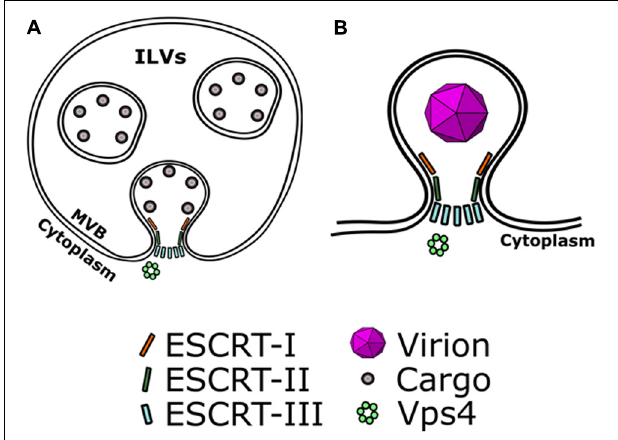
FIGURE 1 | Viruses hijack EV biogenesis mechanisms to mediate their own assembly. The topology of viral envelopment requires constricting budding membranes toward the cytoplasm. (A) ESCRT recruits cargo on the membranes of early endosomes and can catalyze the formation of intra-luminal vesicles (ILVs) that contain ESCRT-recruited cargo. ESCRT-III catalyzes the scission of necks of ILVs. (B) In a similar manner, viruses can co-opt ESCRT to mediate their envelopment. ESCRT-III can catalyze scission of the budding neck of enveloping virions, allowing their